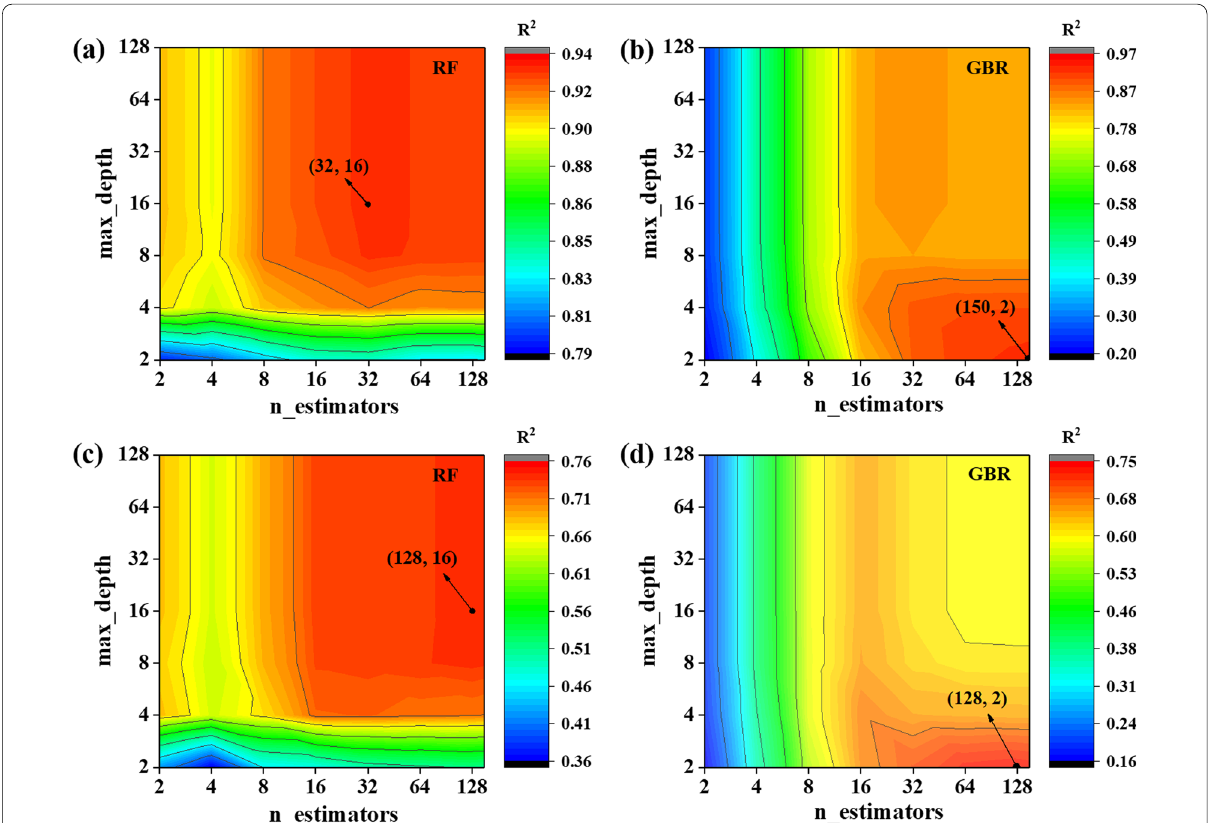
Fig. 2 Hyper-parameter tuning for the prediction of Yield-char from dataset #1_6 ( a , b) and that of three targets from dataset #7_6 ( c , d